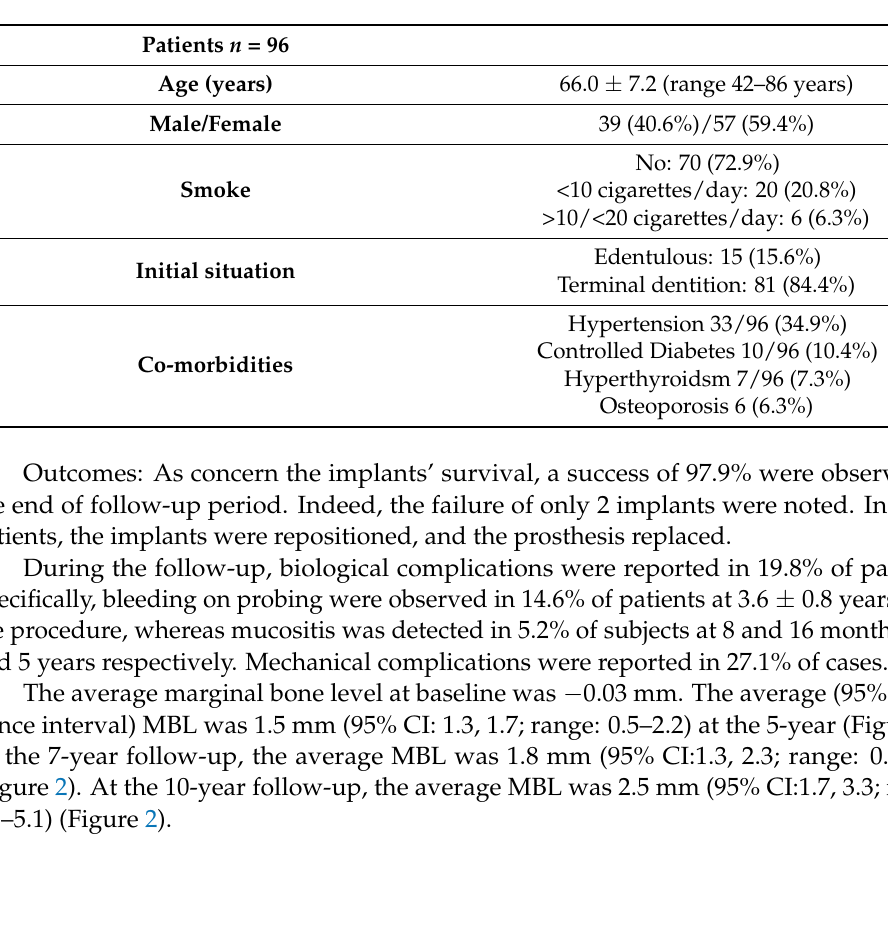
Table 2. Patients’ baseline